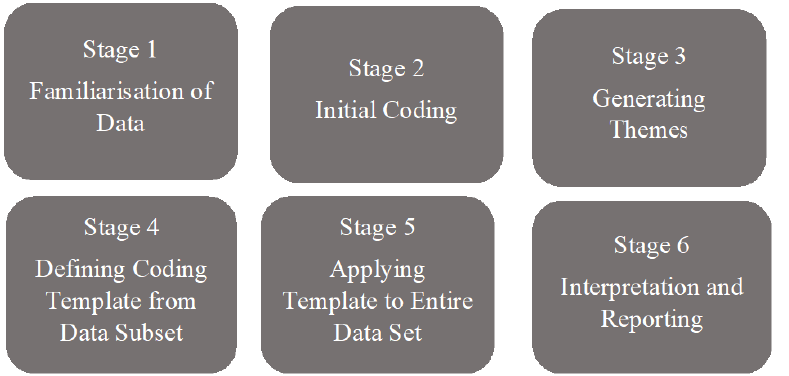
Figure 1. Six Stages of Thematic Template Analysis. Note. Reprinted with permission from: The utility of template analysis in qualitative psychology research by J. Brooks, S. McCluskey, E. Turley, & N. King, 2015, Qualitative Research in Psychology , 12(2), 202—222 [31]. 2022, Taylor and Francis.